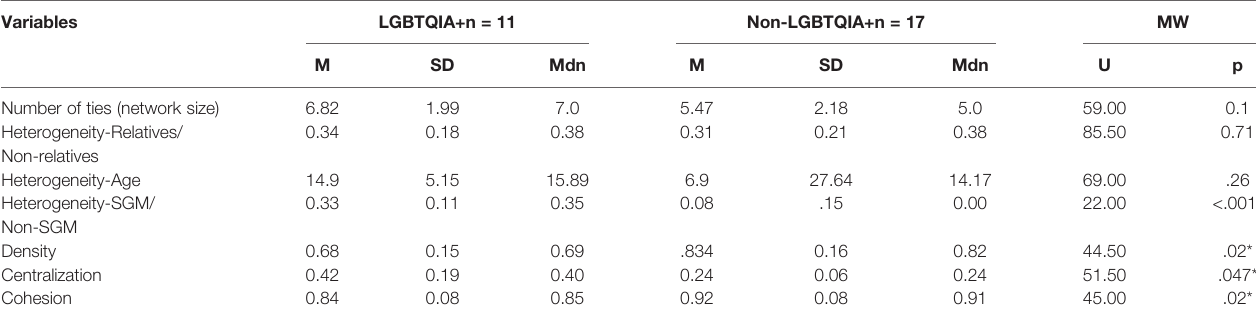
TABLE 2 | Social network characteristics.